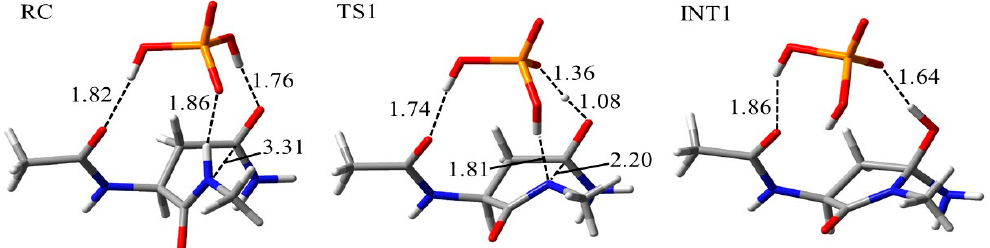
Figure 8. Optimized geometries of the cyclization step for the syn conformation in the phosphate- catalyzed reaction. The carbon, nitrogen, oxygen, and phosphorus atoms are illustrated in gray, blue, red, and orange, respectively. Selected interatomic distances are in units of Å.